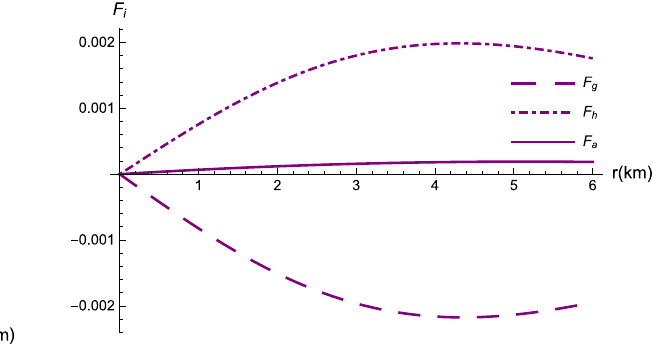
Fig. 15 Behavior of forces in RXJ 1856-37